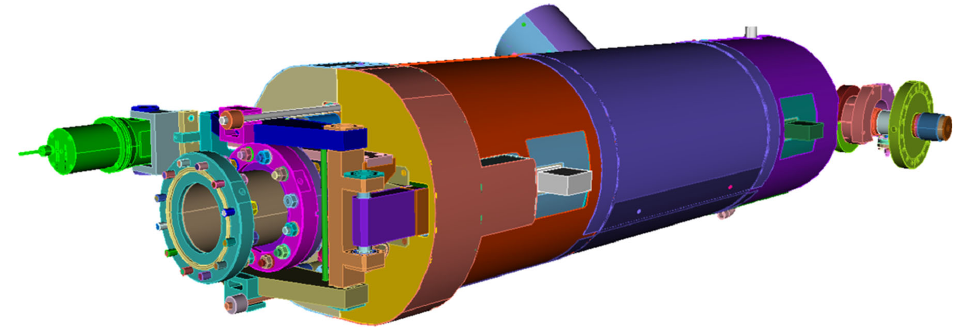
FIG. 1. Illustration of the LCLS-II dressed cavity showing the outer helium vessel wrapped with magnetic shielding, the fundamental power coupler (on the right) and the tuner (on the left) that has both coarse (motor) and fine (piezoactuator) axial positioning